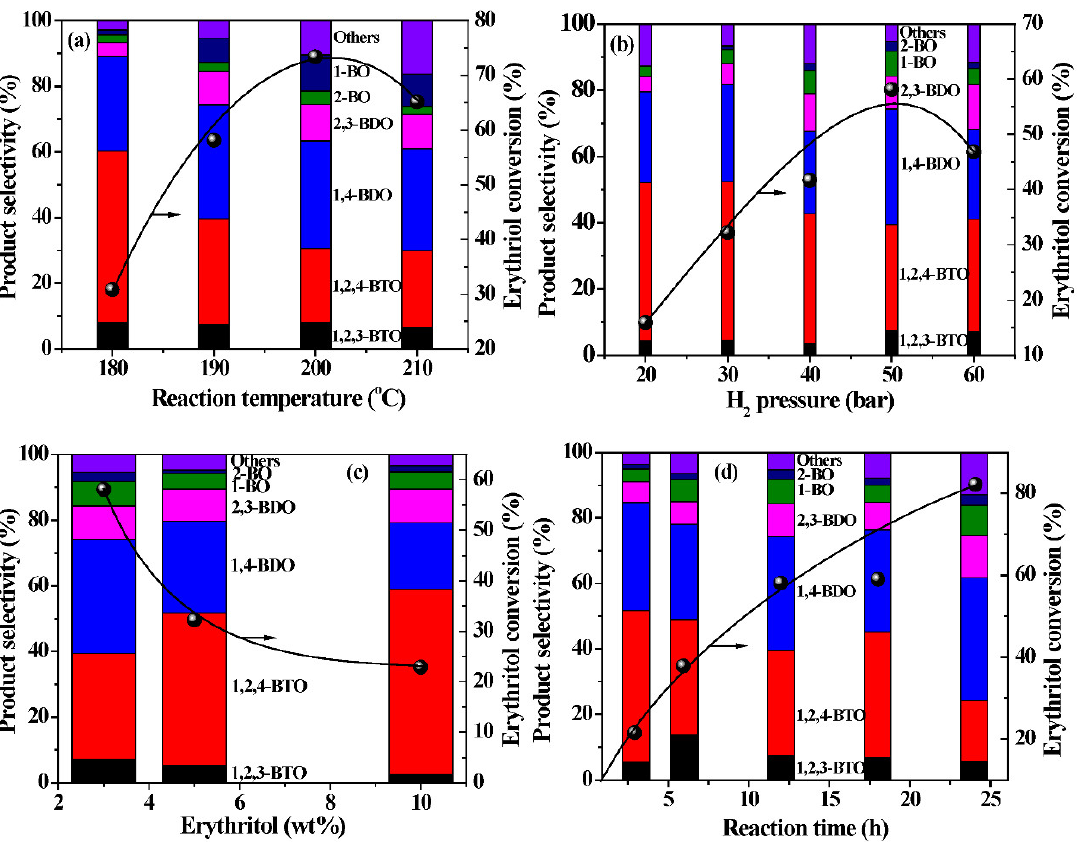
Figure 6. Influence reaction parameters: ( a ) reaction temperature, ( b ) hydrogen pressure, ( c ) erythritol concentration and ( d ) reaction time on the HDO reaction of erythritol.